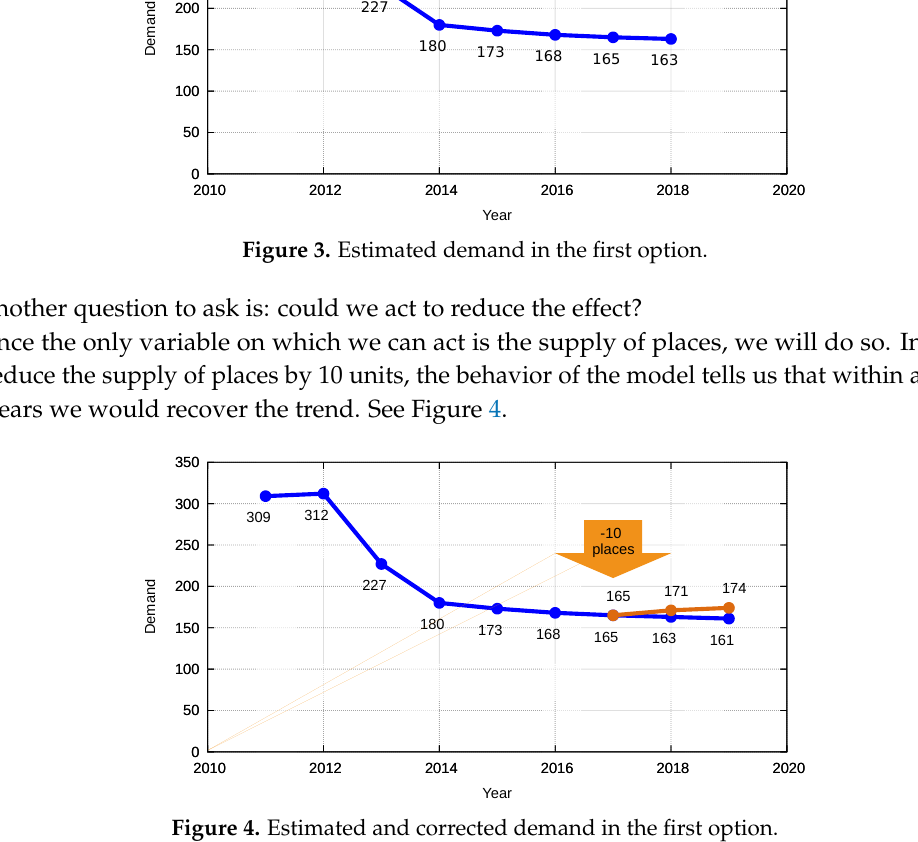
Figure 4. Estimated and corrected demand in the first